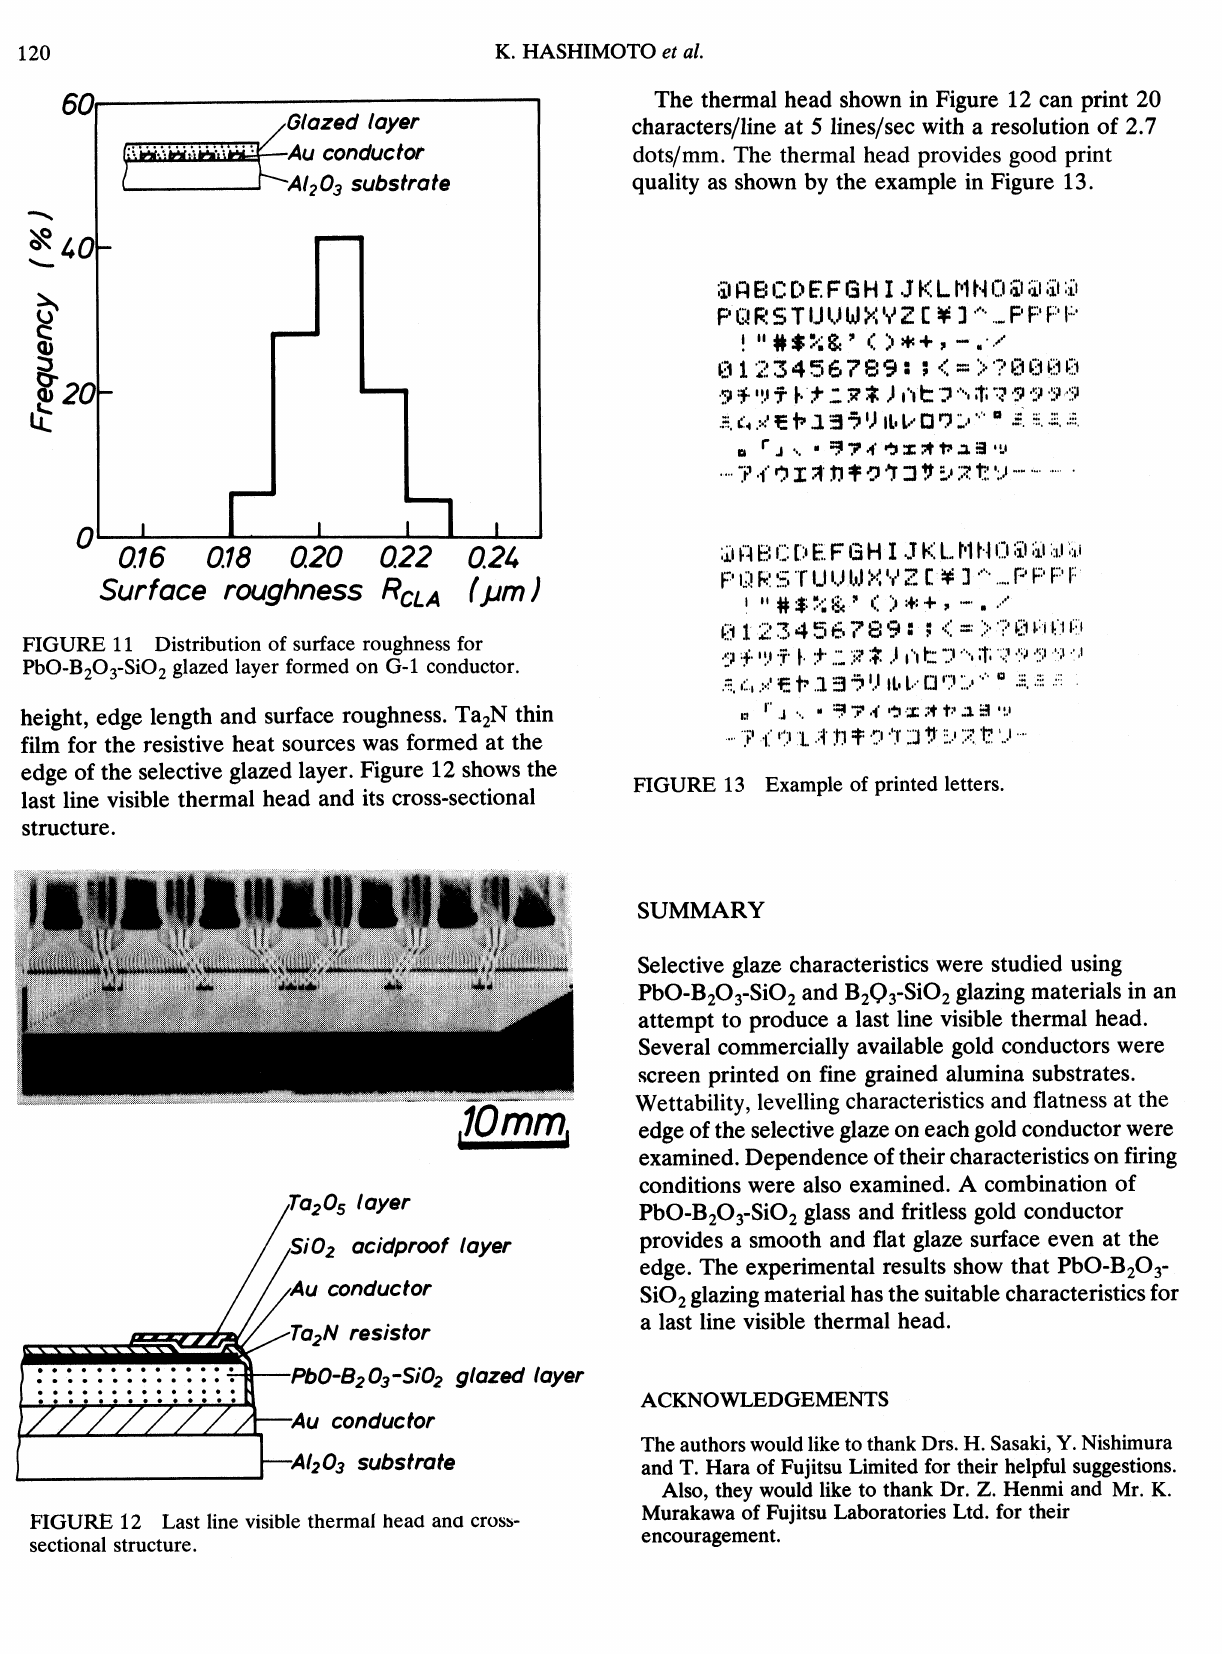
FIGURE 12 Last line visible thermal head and cros- sectional